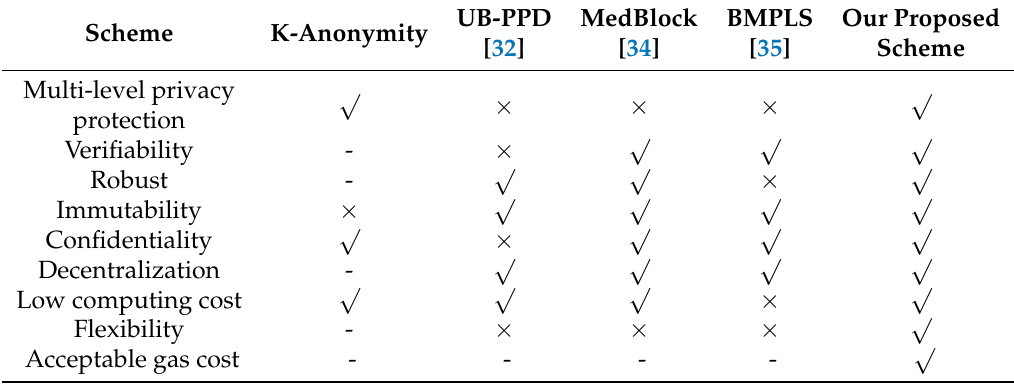
Table 1. Performance comparison with related